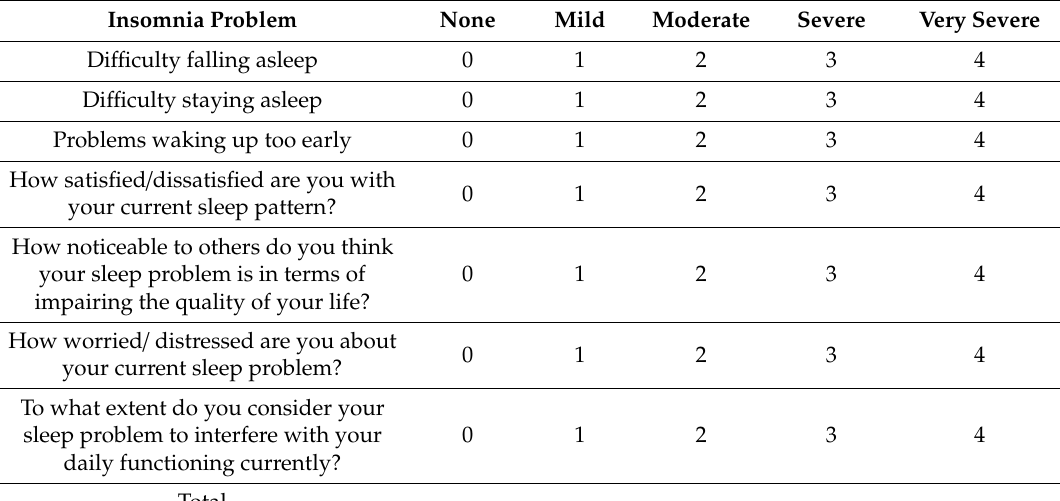
Table A3. Insomnia Severity Index-7 (ISI-7).